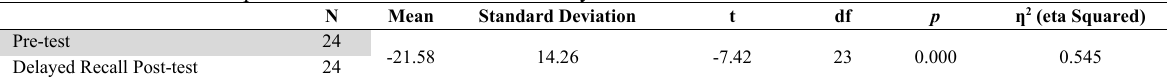
Results of the Paired Samples Test between Pre-test and Delayed Recall Post-test N Mean Standard Deviation t df p ƞ 2 (eta Squared)